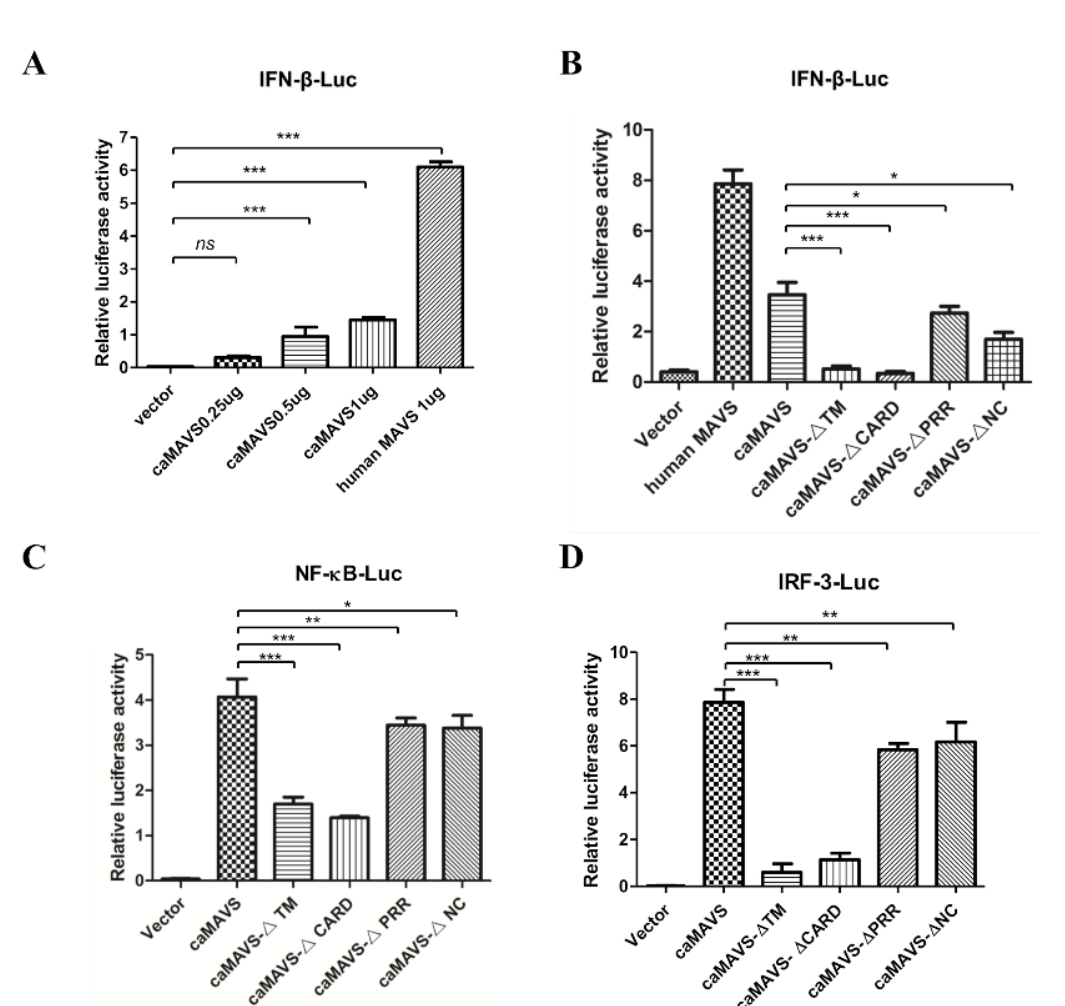
Figure 4. Overexpression of caMAVS induced IFN- β via the NF- κ B and IRF-3-mediated pathways. ( A ) HEK-293T cells were transfected with increasing amount of caMAVS, IFN- β -Luc together with endogenous control pRL-TK Plasmid (40 ng/well). ( B – D ) HEK-293T cells were transfected with caMAVS or its mutants (500 ng) along with PRDII-Luc (NK- κ B-luc), PRDI/III-luc (IRF3-luc)) or IFN β -Luc together endogenous control pRL-TK Plasmid (40 ng/well). Human MAVS was used as a positive control. At 36 hpt, the HEK-293T cells were lysed, and Rluc and Fluc activities were evaluated using the Promega Dual-Luciferase Reporter Assay System. Furthermore, all the experiments were performed at least three times to ensure the results consistency (The data represent the mean ± SD of three independent experiments. One-way ANOVA was used for statistical analysis; * p < 0.05; ** p < 0.01; *** p < 0.001).